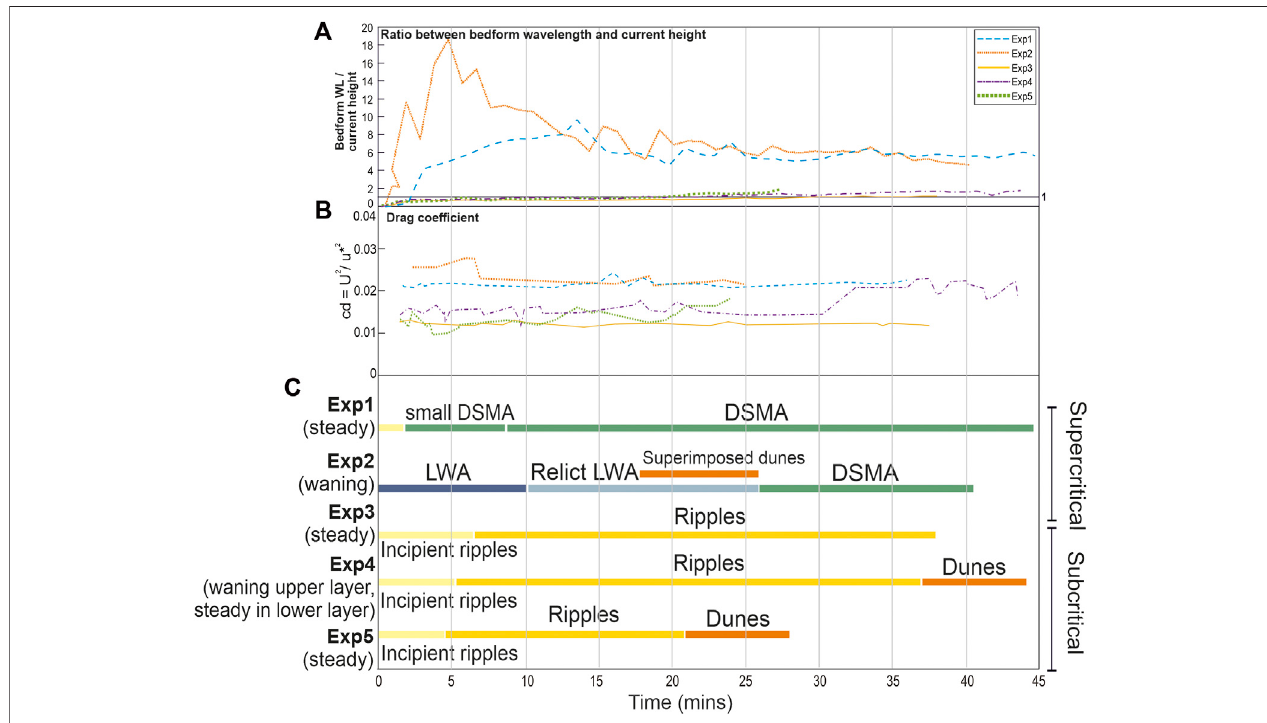
FIGURE6|(A) Ratiobetweenbedformwavelengthandtheheightofthelowerlayerofthecurrent. (C) BedformdevelopmenttimelineforExperiments1 – 5(DSMA, downstream migrating antidunes; LWA, long wavelength antidunes) and (B) the associated drag coef fi cient change.